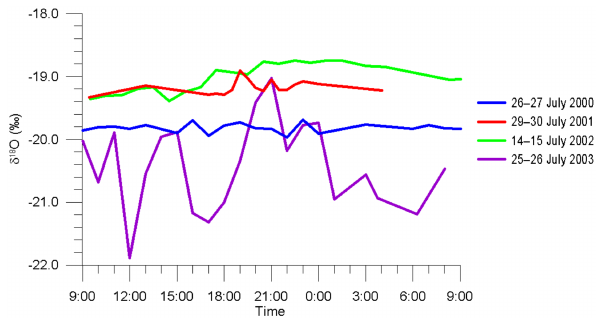
Figure 5. Diurnal δ 18 O variations in the Kuannersuit Glacier river on studied days in July in the post-surge years 2000–2003. Multi- sample tests conducted in 2001, 2002 and 2003 showed standard deviations of ± 0.16, ± 0.13 and ± 0.44‰,